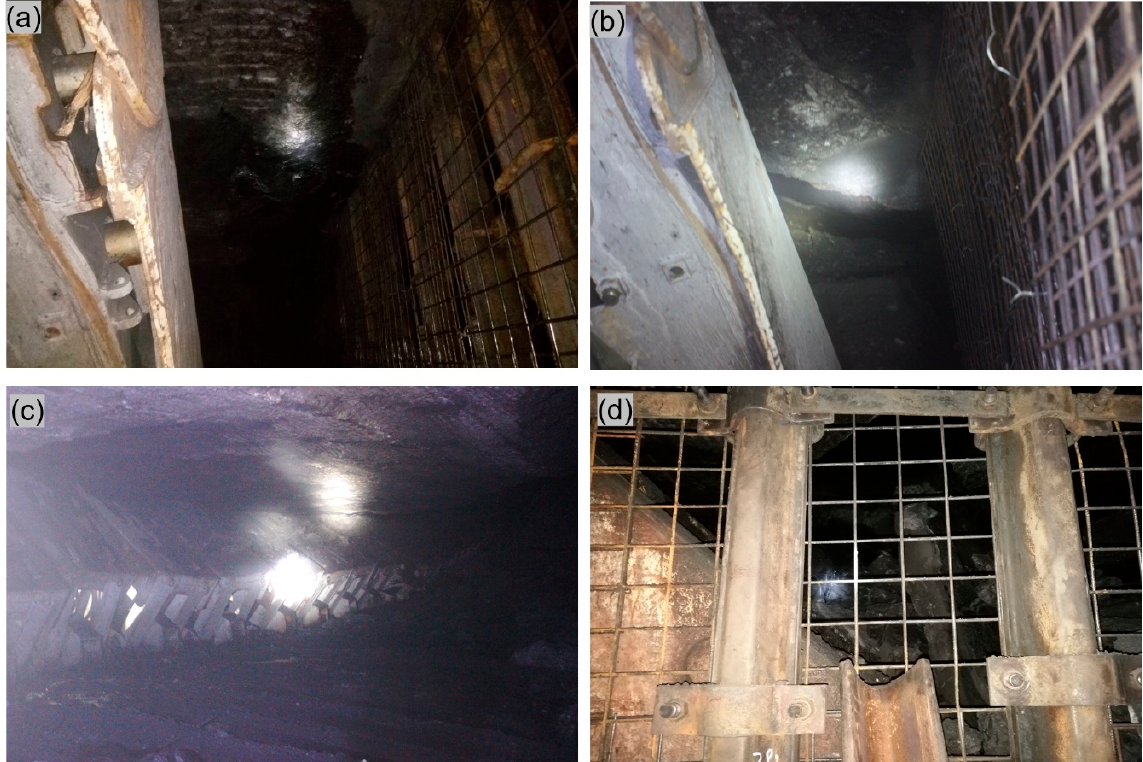
Figure 11. Roof collapse conditions before and after deep-hole blasting ( a ) The roof of the goaf is suspended, viewed from the front of the hydraulic support ( b ) The roof of the goaf is collapsed, viewed from the front of the hydraulic support ( c ) The roof of the goaf is suspended, viewed from the back of the hydraulic support ( d ) The roof of the goaf is collapsed, viewed from the back of the hydraulic support